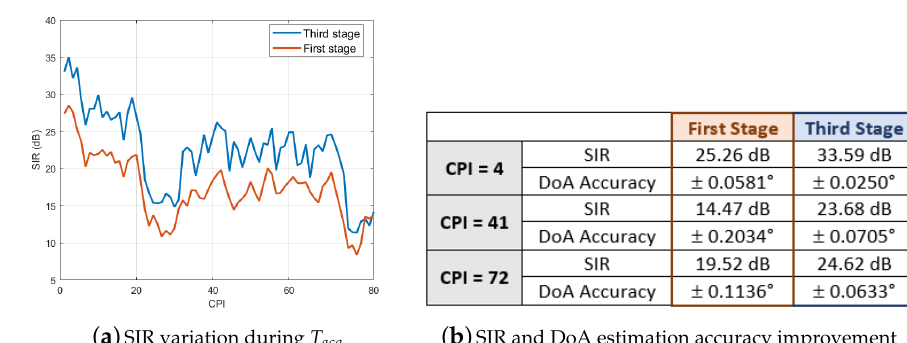
Figure 18. Study of collaborative target SIR and DoA accuracy measured in CAF generated for the 0 ◦ -steered beam associated with the first and third stages of the proposed scheme and T int = 500